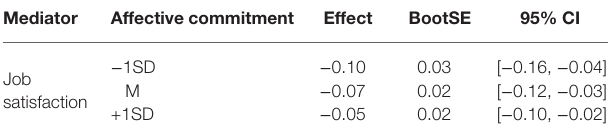
TABLE 5 | Conditional indirect effect of affective commitment when job satisfaction mediated between work-family conflict and work engagement. Mediator Affective commitment